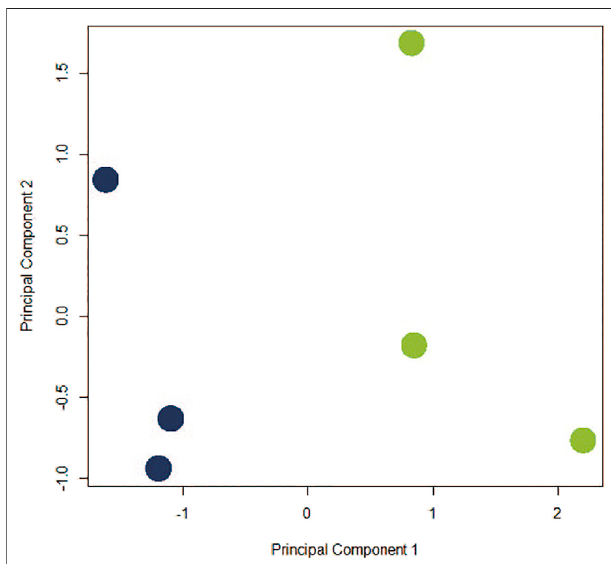
FIGURE 2 | PCA plot depicting co-clustering of gene expression in dissociated replicates (blue) and intact replicates (green). Samples clustered distinctly along PC1 based on method of preparation (negative and positive,